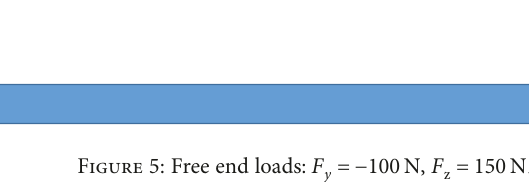
Figure 5: Free end loads: F = − 100N, F = 150N z y Table 2: Comparison of reconstruction accuracies under three placements; displacements expressed in mm. Max deformation in direction, X Max deformation in direction, Y Max deformation in direction, Z ANSYS